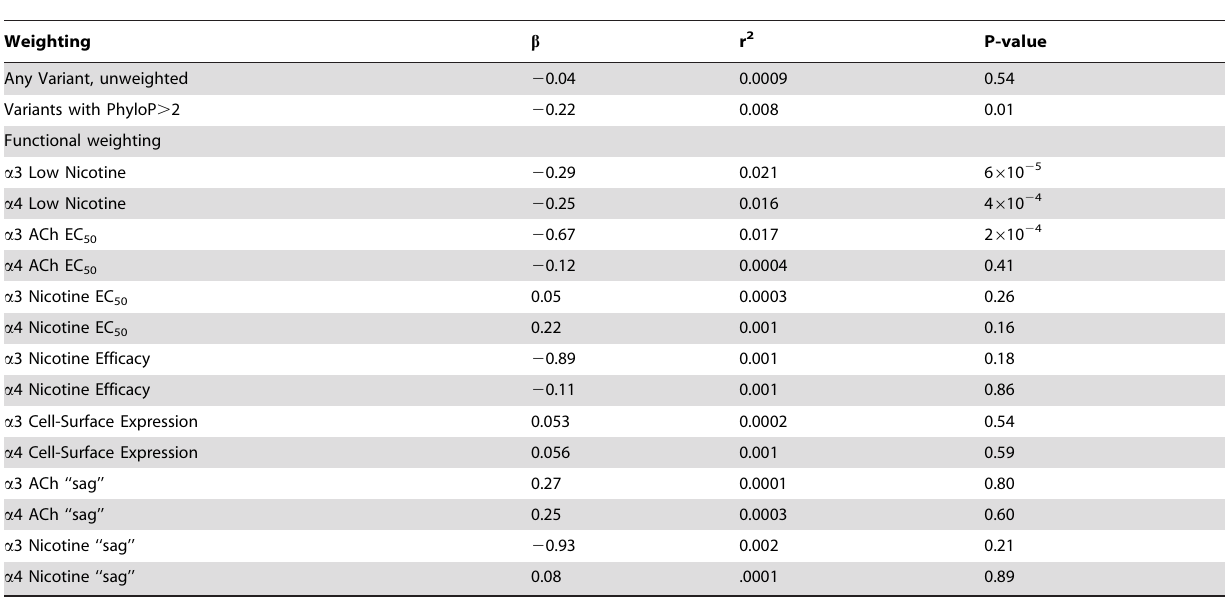
Table 4. Results from parameter-weighted linear regression.